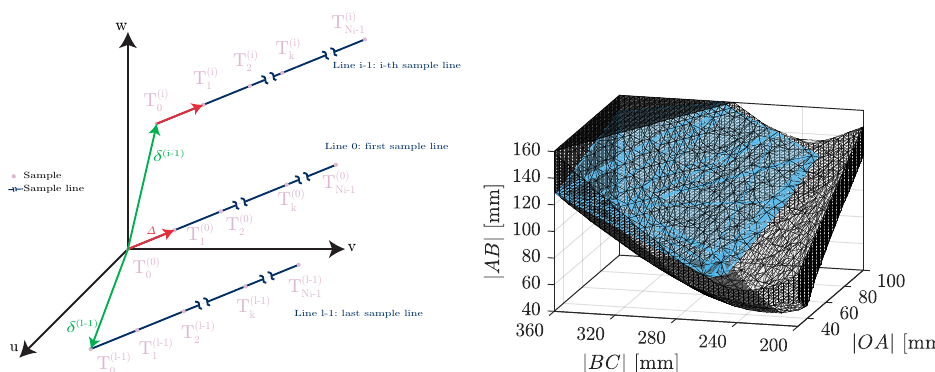
Figure 13. ( left ) All the samples located at points k ∆ + δ ( i ) . The convex hull, in blue, of the l lines covering the larger part of the design space ( right